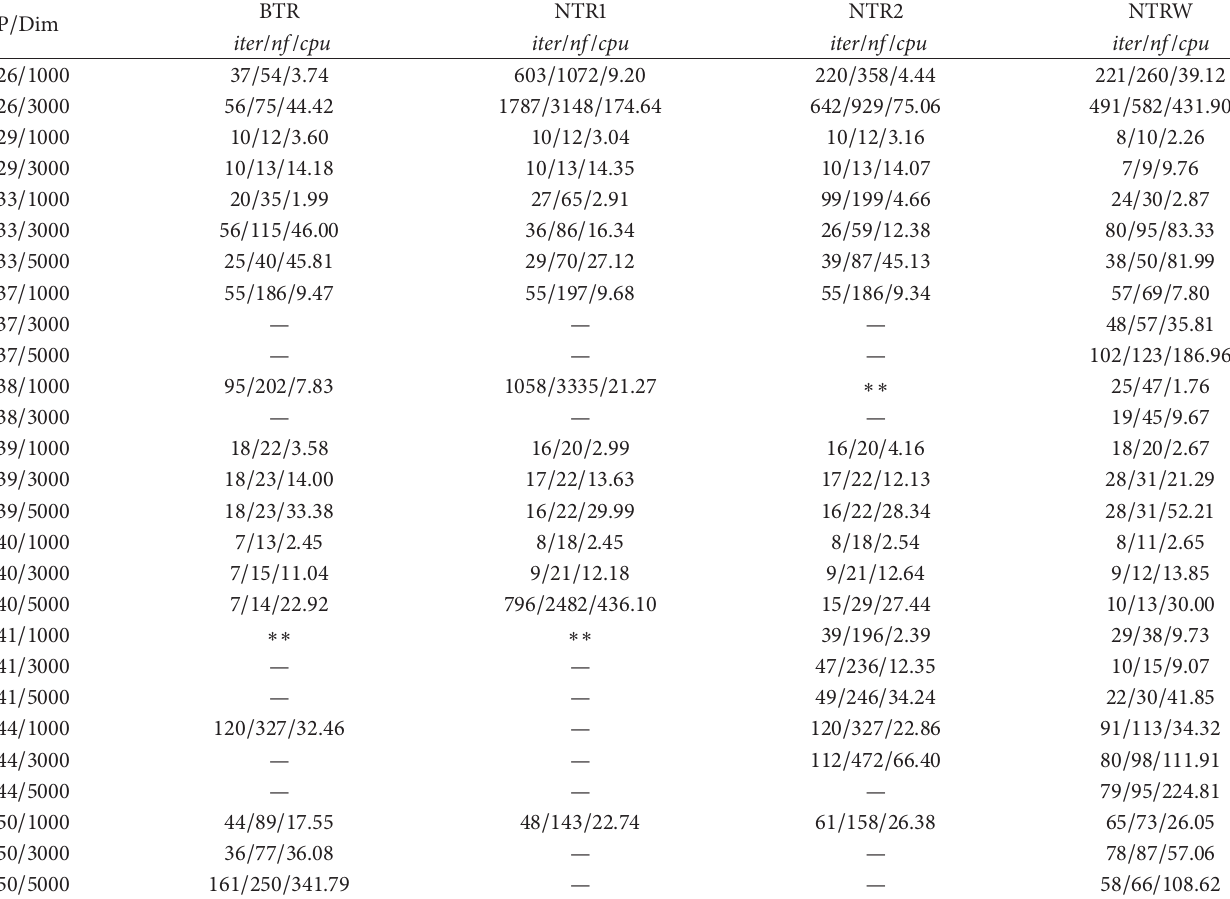
Table 4: Numerical comparisons for some large-scale test